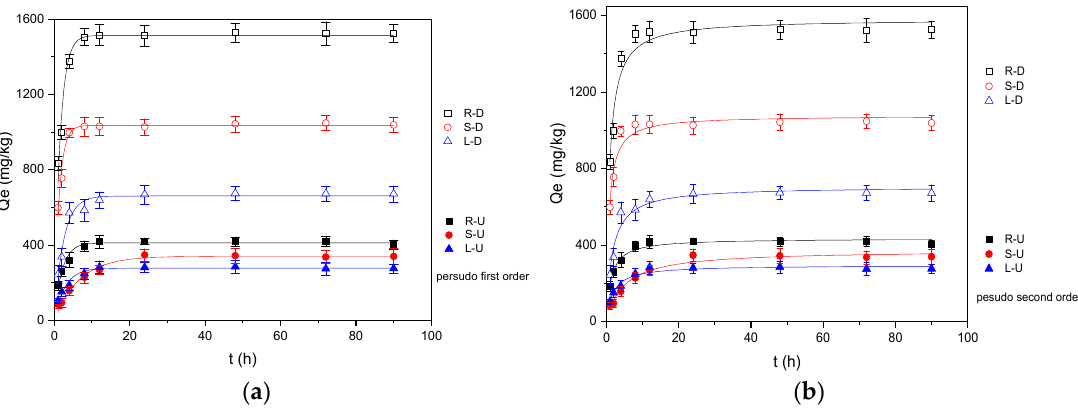
Figure 2. The kinetic model of OTC adsorption by reed residues. ( a ) Pseudo-first-order model; ( b ) pseudo-second-order model.